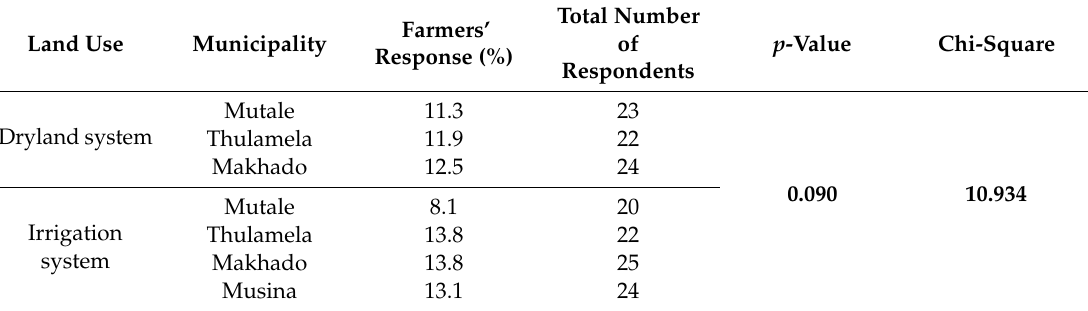
Table 1. Farmers’ awareness of climate change across municipalities in Vhembe